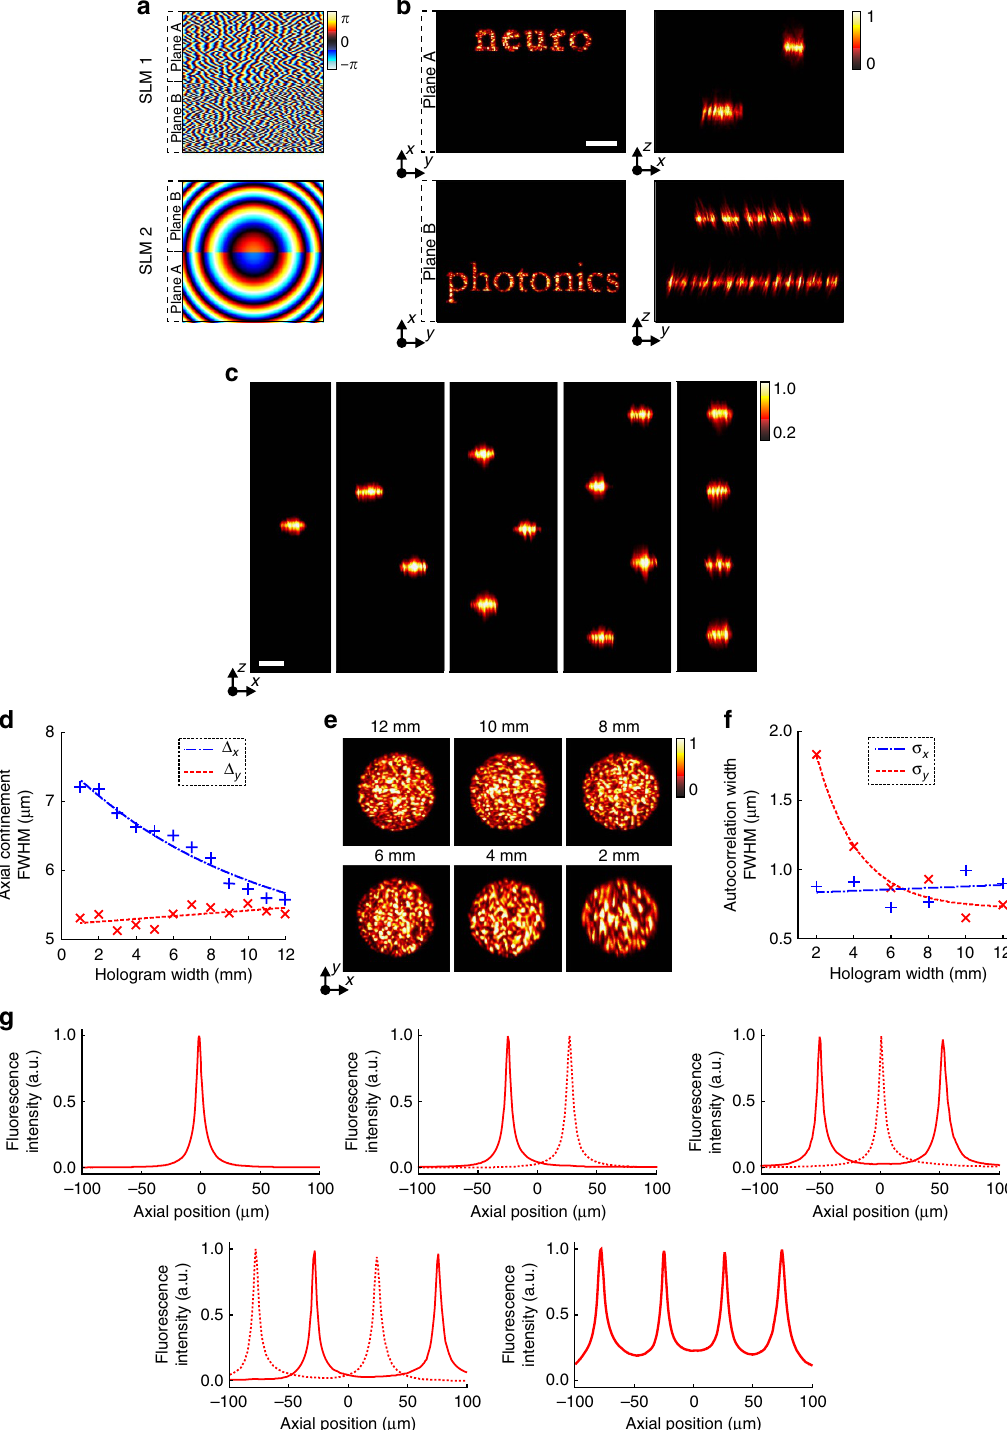
Figure 3 | Multiplane spatiotemporally focused pattern generation. ( a ) Top, tiled phase profiles addressed to SLM1 for encoding the words ‘neuro’ (plane A) and ‘photonics’ (plane B). Bottom, Fresnel lens-phase profiles addressed to SLM2 to axially displace each holographic pattern generated by SLM1 on separated planes at þ 20 m m (plane A) and (cid:2) 20 m m (plane B). ( b ) Left, x–y 2P fluorescence intensity cross-sections at planes A and B generated by the holograms in a . Right, orthogonal maximum 2P intensity projection along x (top) and y (bottom). ( c ) Orthogonal fluorescence intensity projection of spatiotemporally focused patterns created by projecting 20- m m-diameter holographic spots in one, two, three and four planes at positions laterally shifted and in four planes at positions axially aligned (from left to right). Scale bars, 20 m m. ( d ) Axial confinement (FWHM) of a 20- m m-diameter holographic spot for different hologram widths, tested in both directions, D x (blue data) and D y (red data) parallel and perpendicular to grating’s dispersion, respectively. ( e ) x–y 2P fluorescence intensity cross-sections of a 20- m m-diameter holographic spot generated with different hologram widths D y . ( f ) Autocorrelation width at the sample plane of a 20- m m-diameter holographic spot as a function of the hologram width along the x - (blue data; s x ) and y directions (red data; s y ). ( g ) Axial profile of the integrated fluorescence intensity of the holographic spots shown on c . Colour bars refer to normalized